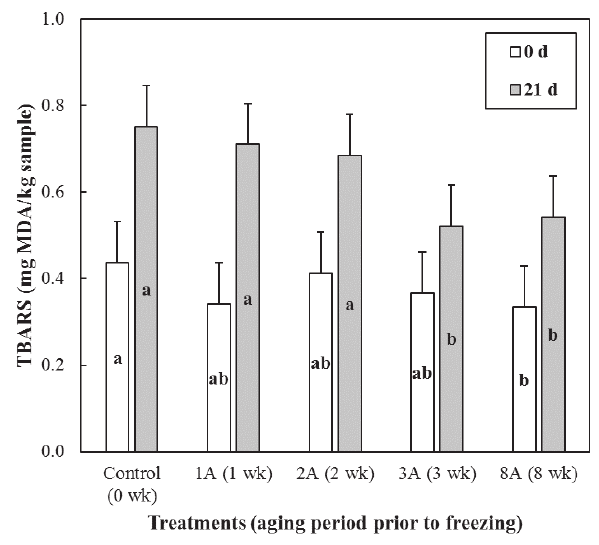
Figure 1. 2-Thiobarbituric acid reactive substances (TBARS) value of cooked model sausages formulated with aged/frozen/thawed lamb loins on 0 and 21 d of display storage. Treatments: lamb loins were collected at 2 d post-mortem, aged (0, 1, 2, 3, and 8 wk) and frozen for each remaining period, respectively. The total period for the ageing and freezing process was equally 30 wk. a,b Means within different letters in each storage period indicate differences between treatments